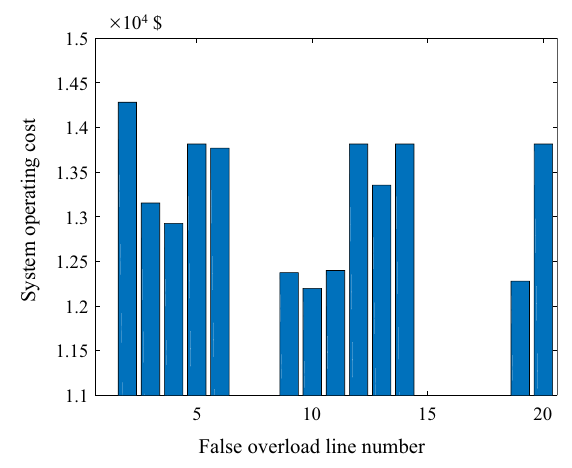
Fig. 6 Operating cost under false overload conditions